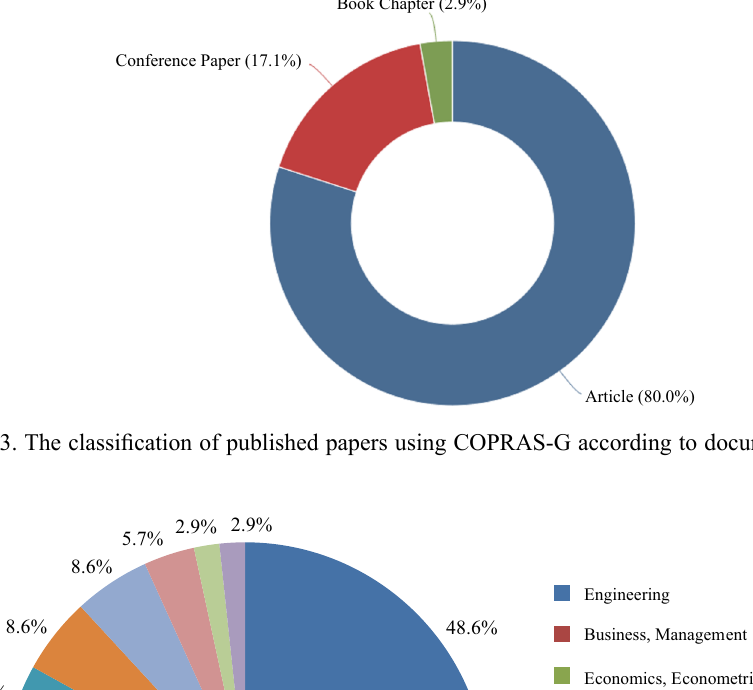
48.6% 37.1%28.6%17.1%8.6%8.6%